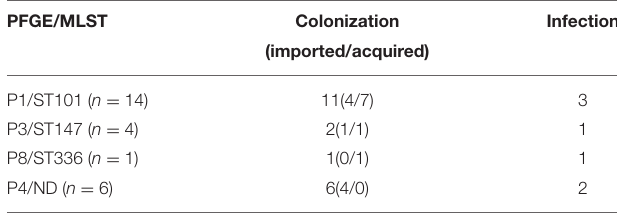
TABLE 4 | Comparison of ST types bacteria: colonization vs.